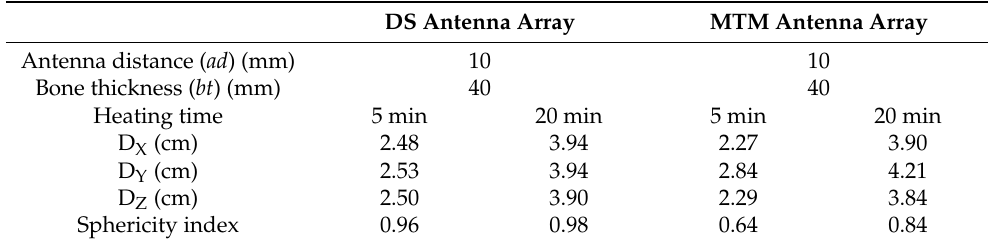
Table 6. Best-case scenarios of ablation zone dimensions for 5 min and 10 min (9 W) for the trian- gular configurations of DS and MTM antennas.